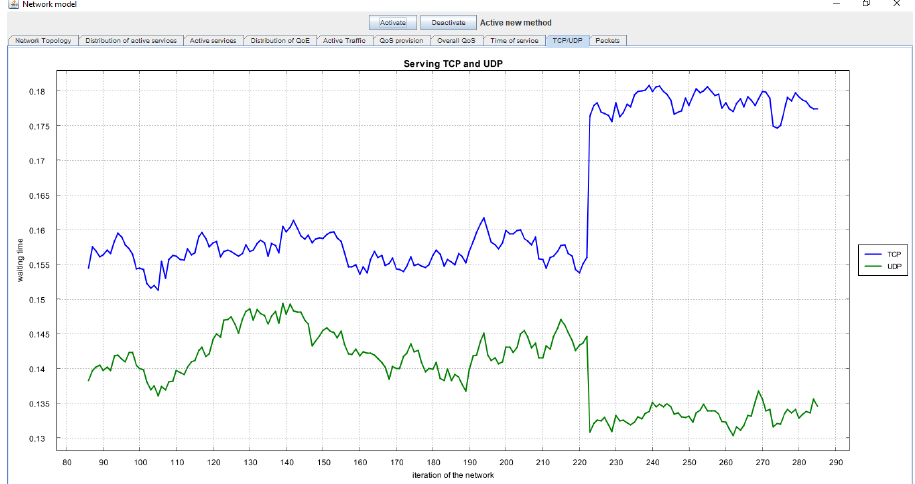
/ UDP services using the proposed Figure 32. The average waiting time for TCP/UDP services using the proposed method. Figure 32. The average waiting time for TCP